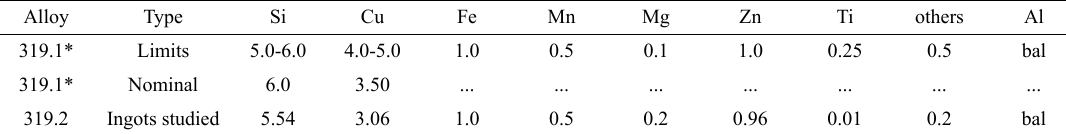
Table 1. Chemical Composition of 319 (Al-5Si3Cu) aluminum alloy (wt %). (*) Ref. 2.